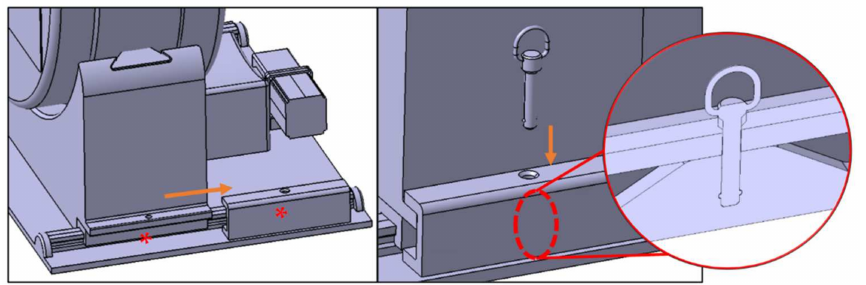
Figure 14. Locking mechanism for stowing.